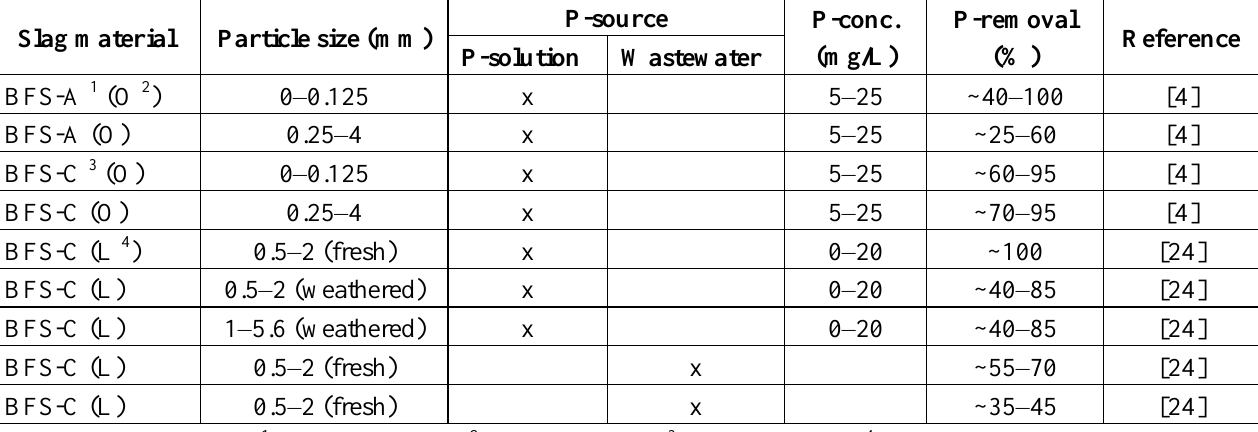
Table 2. P retention capacity estimated from laboratory batch experiments using laboratory made P-solutions and real-life domestic